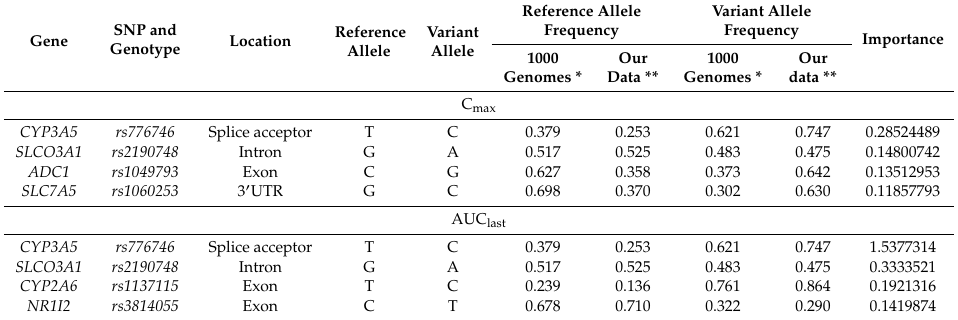
Table 2. Top four genetic variants for tacrolimus C max and AUC last identified in the random forest analysis.